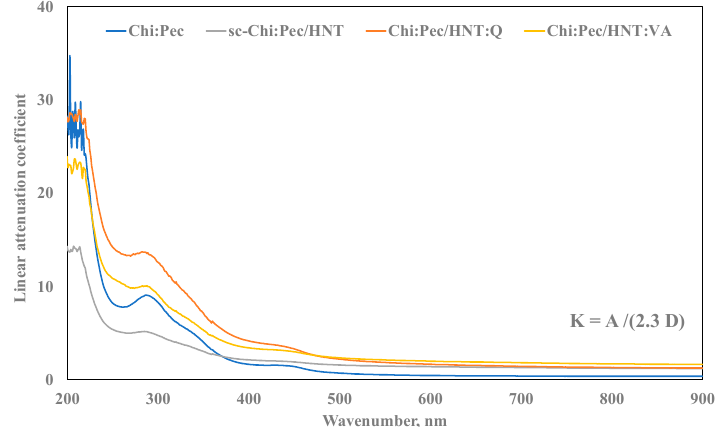
Figure 3. Linear attenuation coe ffi cient (K) of Ch:P and Ch:P containing HNT without and with natural antioxidants.